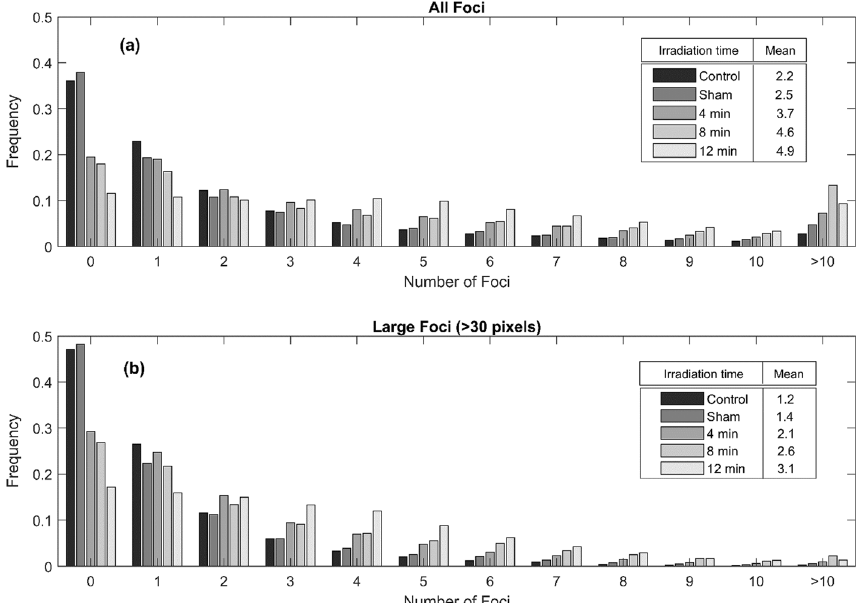
Fig. 4 Detected γ‑H2AX foci distribution per nucleus after alpha irradiation for 4, 8, and 12 min with the 214 Am source. In sham‑irradiated cell, the cell culture media was removed for 12 min. a Detected distribution considering foci larger than 9 pixels. b Detected distribution considering foci larger than 30